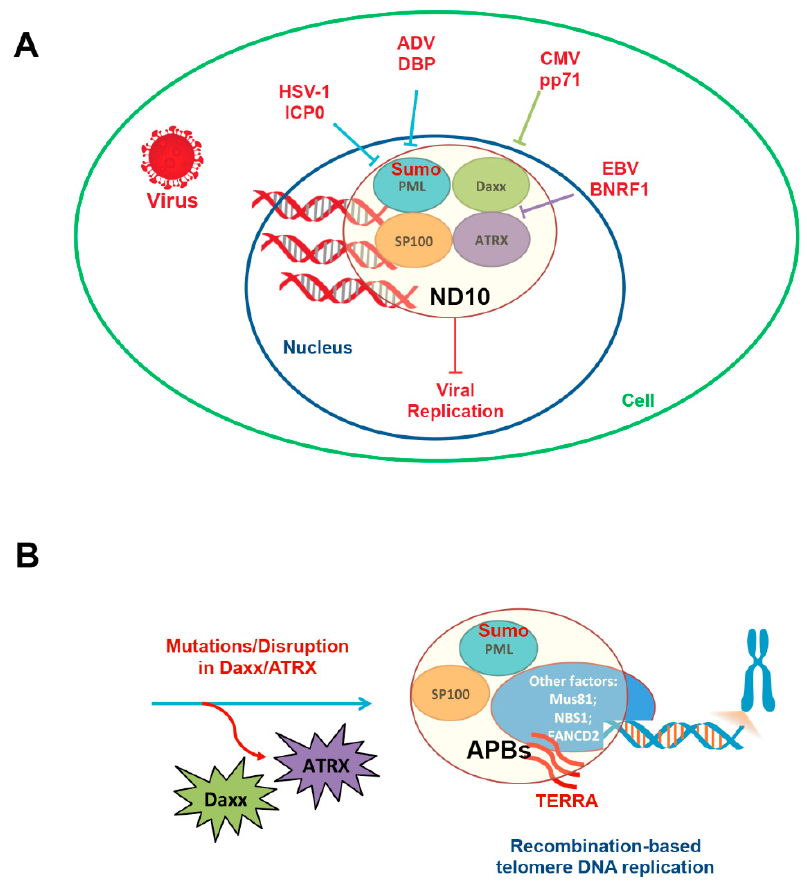
Figure 2. Role of PML-nuclear bodies (PML-NBs, or ND10) in regulating virus infection and telomere dysfunction. ( A ) PML-NBs can form at viral genomes to prevent viral infection. Viruses encode numerous factors that disable or degrade PML-NB components to enable viral infection or establishment of latency; ( B ) PML-NBs that have mutations in ATRX or Daxx can interact with telomeres to enable ALT. Telomere repeat-containing RNA (TERRA) is expressed at high-levels in ALT and during some viral infections. ADV DBP: DNA binding protein; APBs: ALT-associated PML-bodies; CMV: Cytomegalovirus; SUMO: small ubiquitin-like modifier.